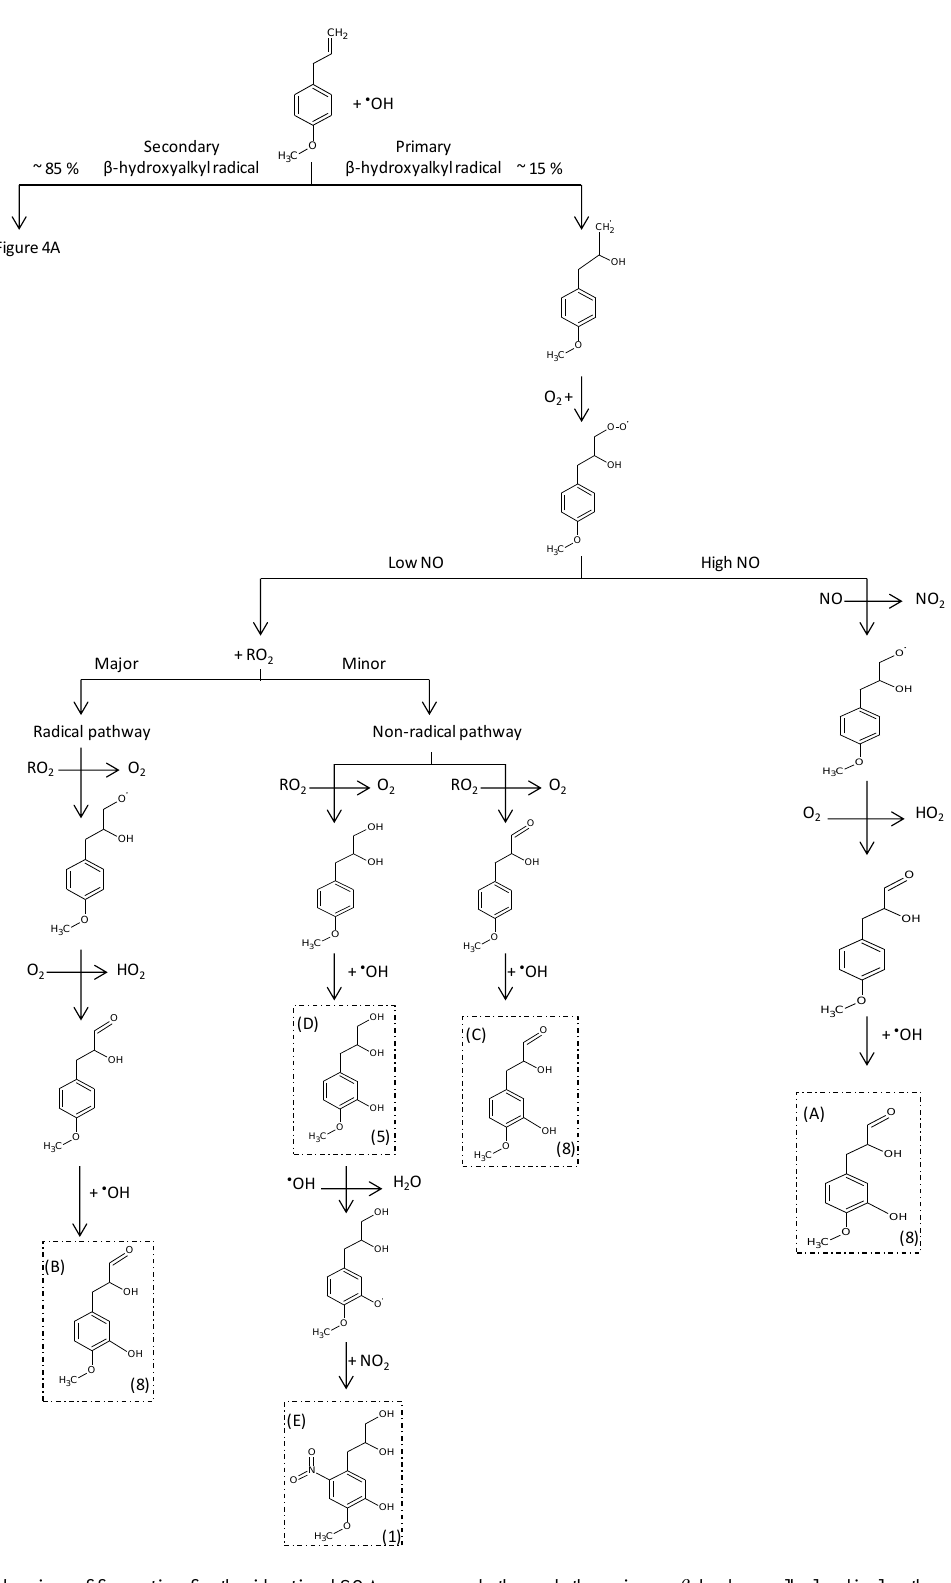
Figure 4. (b) Mechanism of formation for the identified SOA compounds through the primary β -hydroxyalkyl radical pathway, compounds 1, 5 and 8, shown in brackets, refer to Table 2 for compound identification. See text for the explanation of the mechanism, letters refer to the explanation in the text. Boxes highlight identified SOA